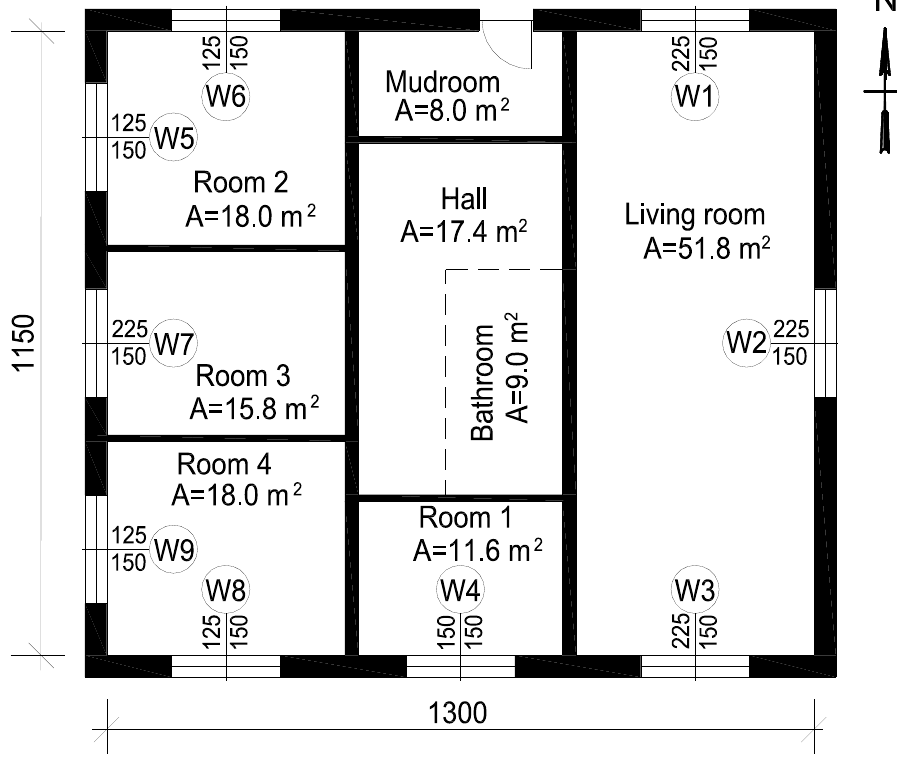
Figure 2. Ground floor view, dimensions are in cm.